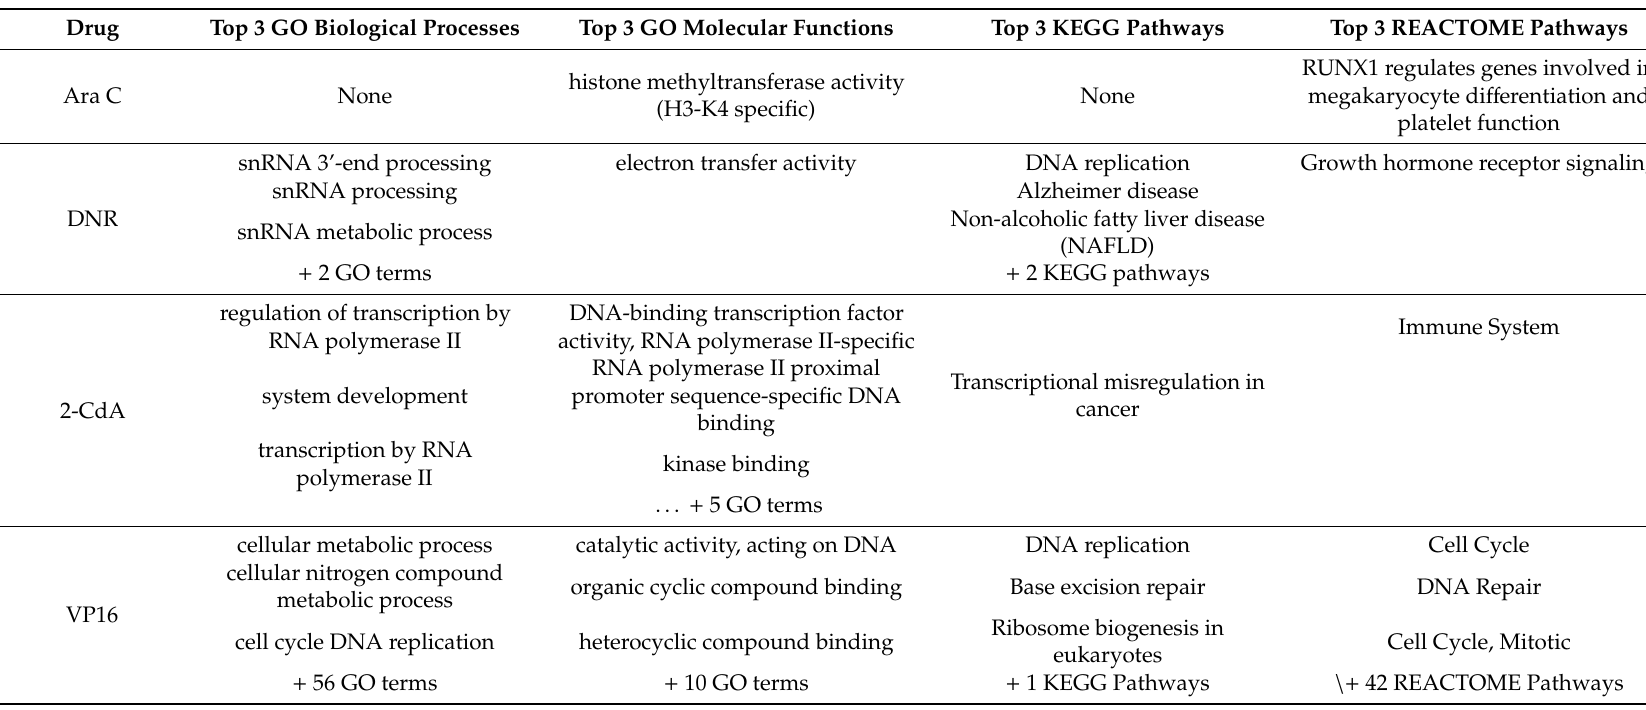
Table A4. Summary of Gene Ontology and Pathway analyses. Top 3 Gene Ontology (GO), KEGG and REACTOME terms are displayed, based on p